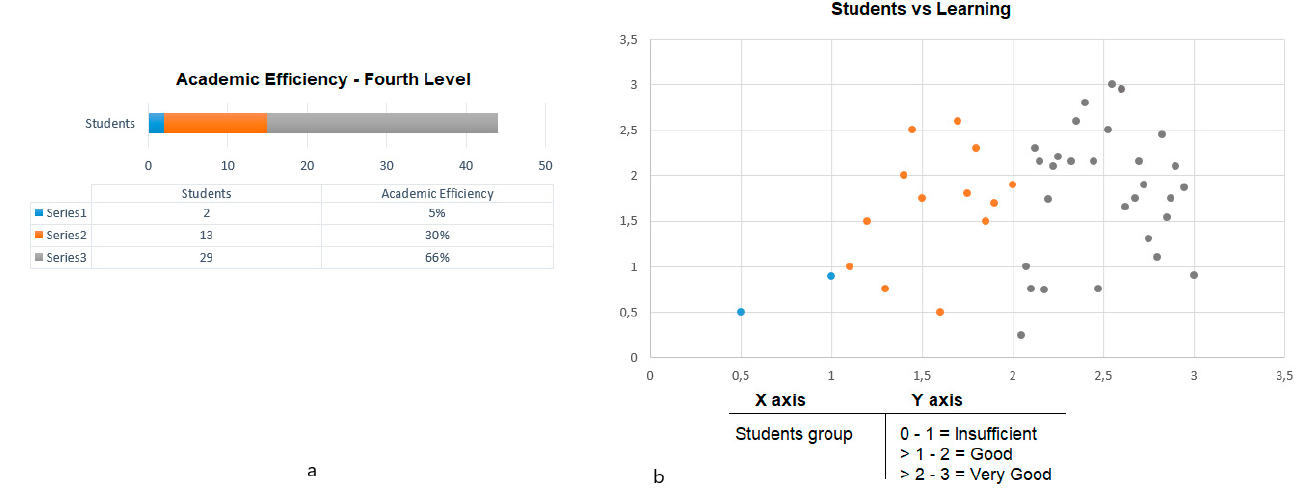
Figure 8. Evaluation of academic effectiveness vs. the learning of fourth-level students. Table 1. Assessment rubric with levels of learning scope.